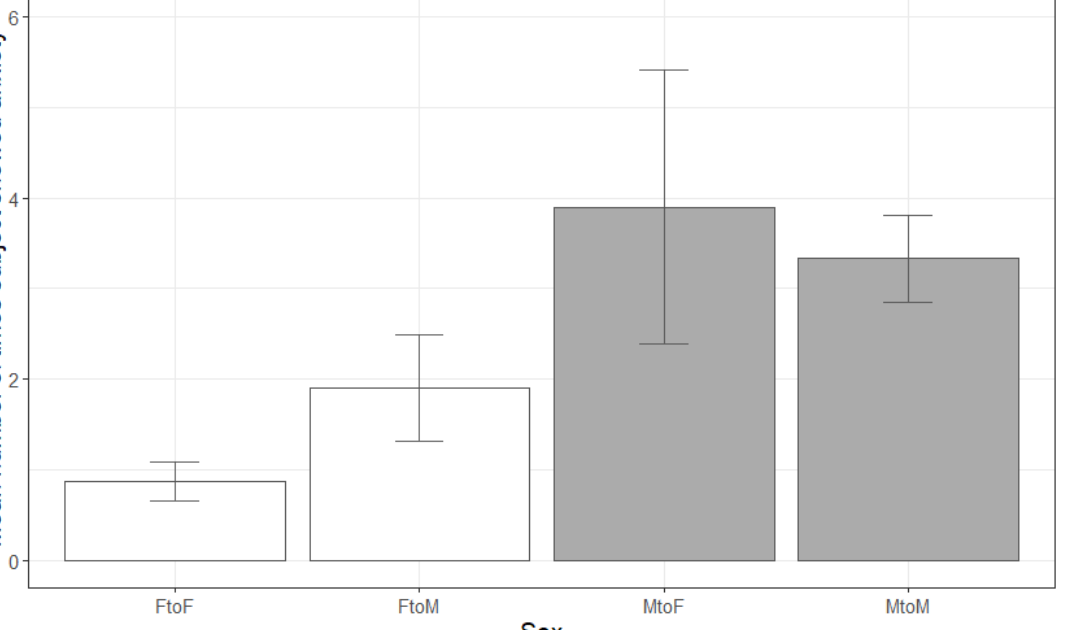
Figure 2. Mean and standard error of number of times individuals showed anxiety during the 10 min Zoom session based on sex of the individual and Zoom partner. On average, males showed more anxiety than females, regardless of whether the Zoom partner was male or female.